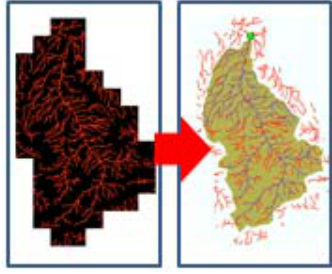
Figure 15. Watershed processing. Right, the extracted network for the DTM, left the result for the calculated